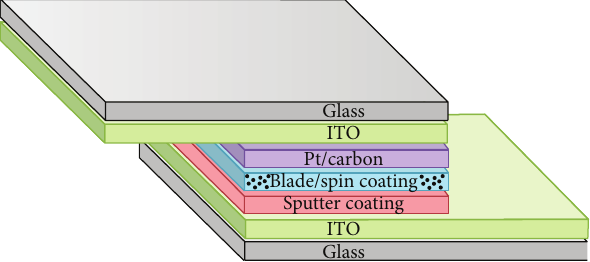
Figure 1: A schematic diagram of a DSSC with an rf-sputtered TiO 2 compact layer/ITO/glass on the ITO